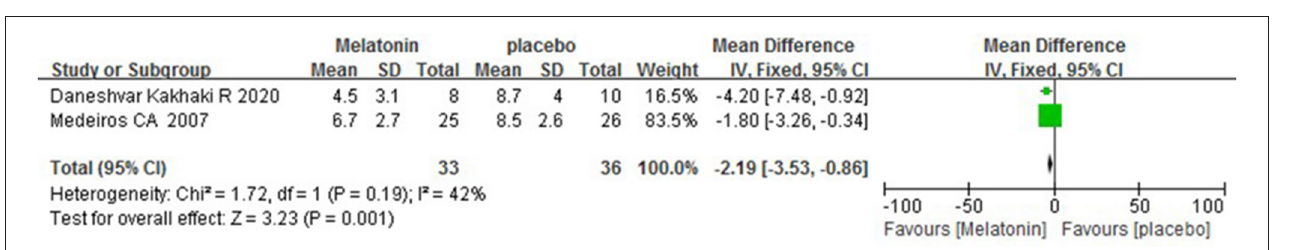
FIGURE 3 | Forest plot of the efficacy of melatonin on the subjective sleep quality of patients with